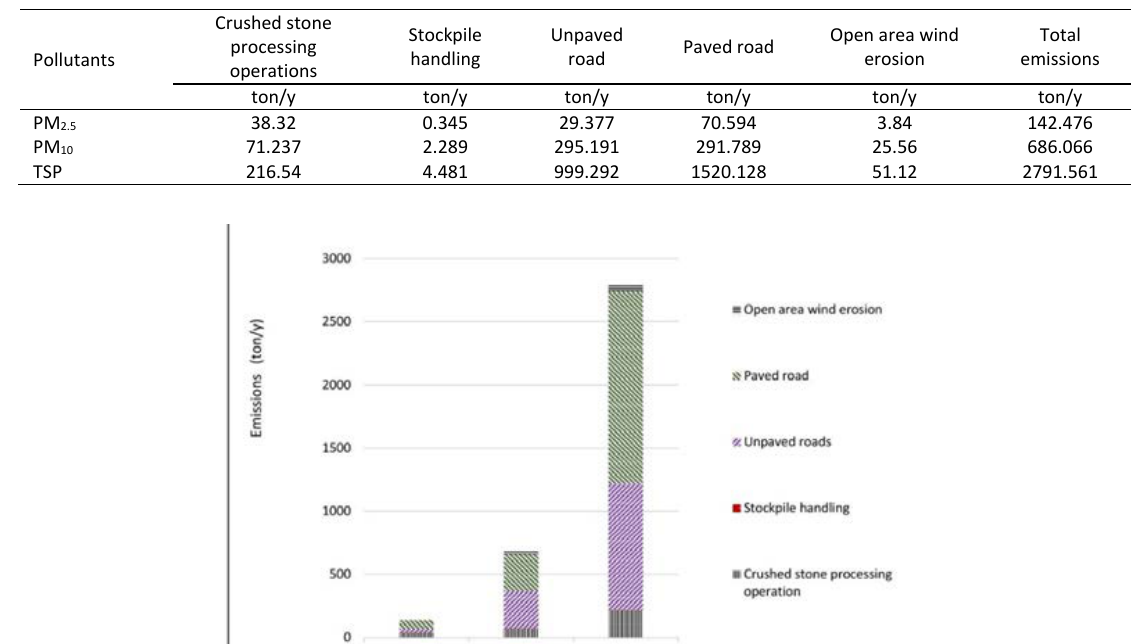
Table 5: Emissions from various pollutant sources in the sand and gravel mining complex